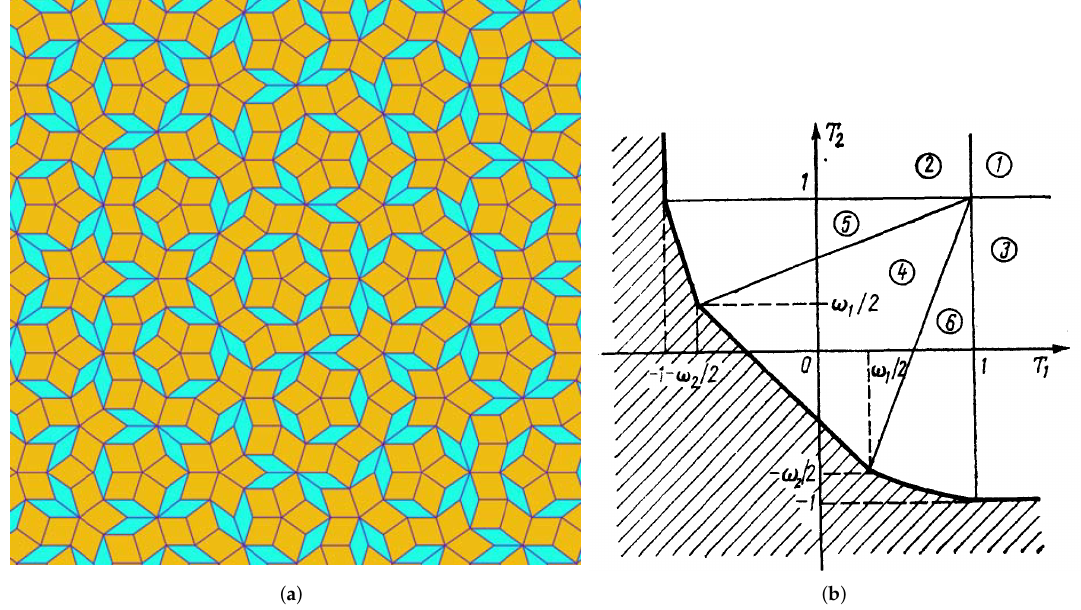
Figure 7. ( a ) The shape of the decagonal quasiperiodic pattern, reprinted with permissions from Ref. [103]. ( b ) The stability chart for patterns composed of five amplitudes, A 1,2,3,4,5 , in the plane of nonlinearity coefficients, T 1 and T 2 , of the respective system of equations (101), reprinted with permissions from Ref. [9]. Stability areas of the rolls (107), rectangles (108) and (109), decagonal quasicrystal (110), and semi-periodic states (111) and (112) are denoted by encircled numbers 1, 2, 3, 4, 5, and 6, respectively. Constants ω 1 and ω 2 , marked in panel (b), are defined by Equation